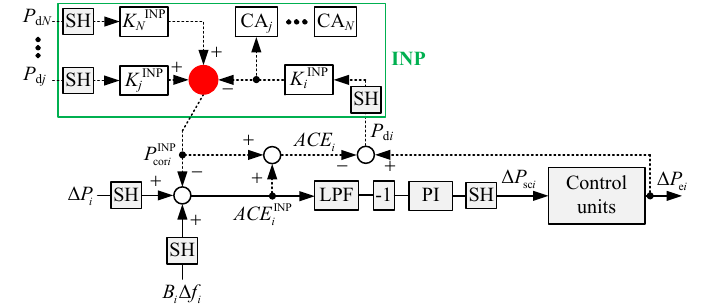
Figure 3. Schematic block diagram representation of the LFC in the CA i (solid line) with the INP (solid and dotted